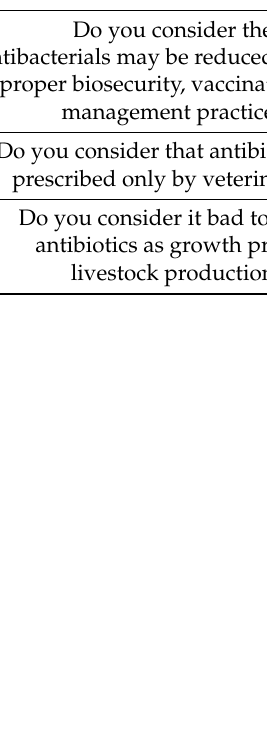
Table 5. Mean knowledge, attitude, and practice scores across sociodemographic